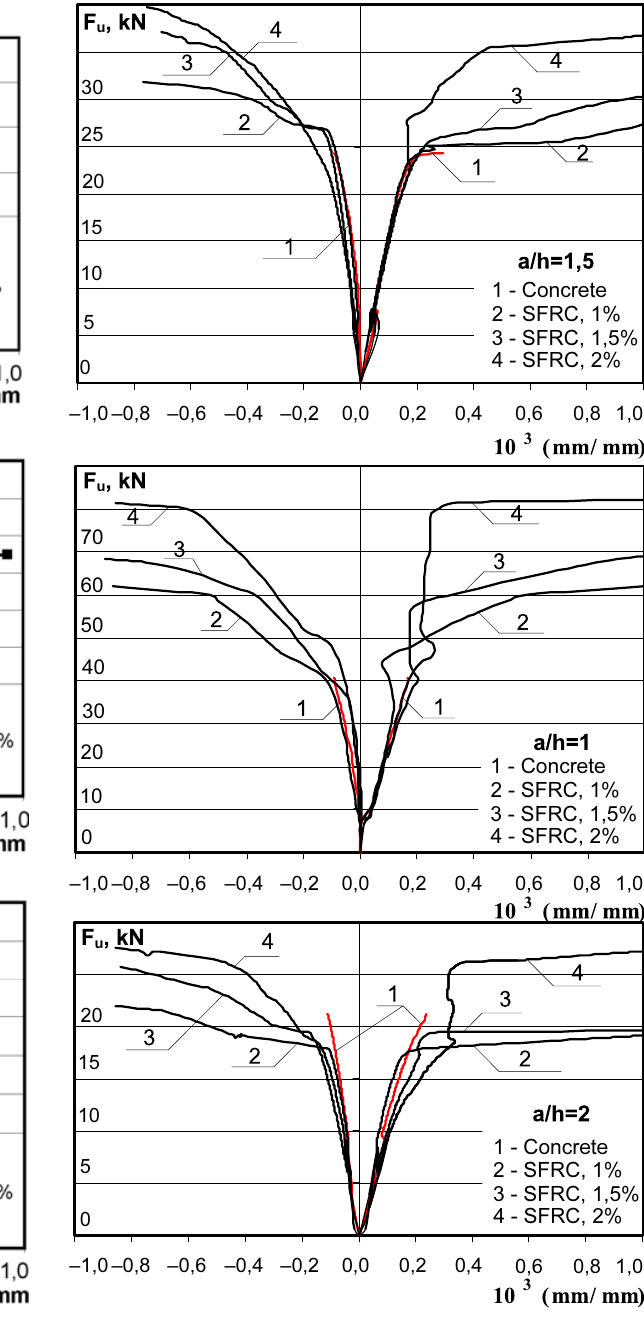
Fig 7. Tension and compression strains with various fibre volumes V and shear span ratios / a h f Fibre volume has a significant influence on plasticity and compression zone of the element. With small normal crack destroys compression zone in nearly the same manner as in the concrete element. With the in- crease of V , compression zone plastic hinge is formed f like one in simple bending beam. Besides, fibre volume has significant influence on the height of compression zone. Experiments show that the average height of com- pression zone at 0,5 F , was equal to 64–65 mm in u